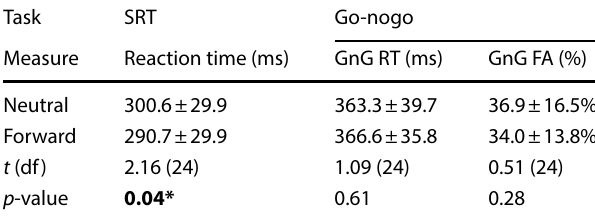
Fig. 4 2 × 3 ANOVA comparing the effects of head position on neck flexion angle (degrees), with factors for condition (solid blue = neu- tral posture; red stripes = forward posture) and task (baseline, sim- ple reaction time (SRT), and go-nogo). Error bars represent stand- ard error. Asterisks represent significant effects ( p < 0.05).* Main effect of condition showing that neck flexion was greater in the for- ward condition than in the neutral condition